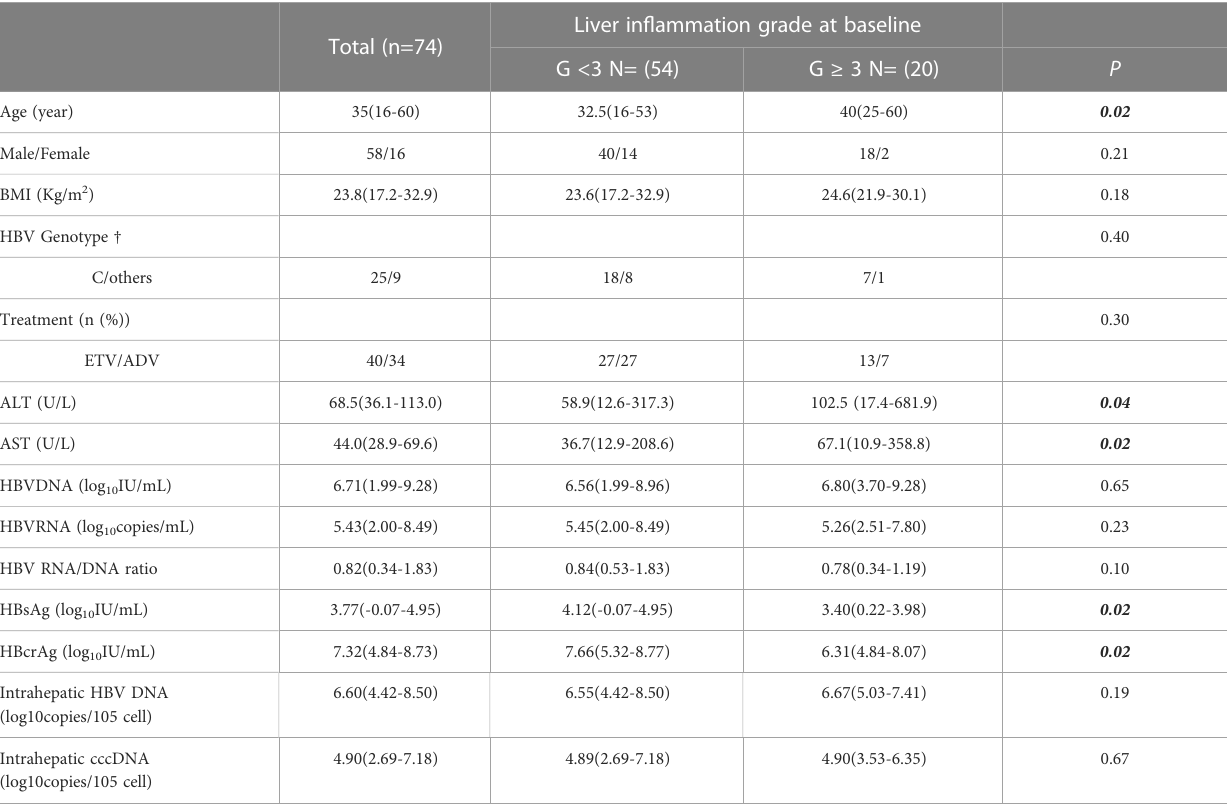
† Thirty-four patients with available genotype data were analyzed. Continuous variables are expressed as medians and ranges; categorical variables are expressed as frequencies. ALT,alanineaminotransferase;AST,aspartateaminotransferase;BMI,BodyMassIndex;ETV,Entecavir;ADV,Adefovirdipivoxil;HBsAg,hepatitisBsurfaceantigen;HBcrAg,hepatitisBcore- related antigen; HBeAg, hepatitis B e antigen; cccDNA, covalently closed circular DNA. P values <0.05 are shown in